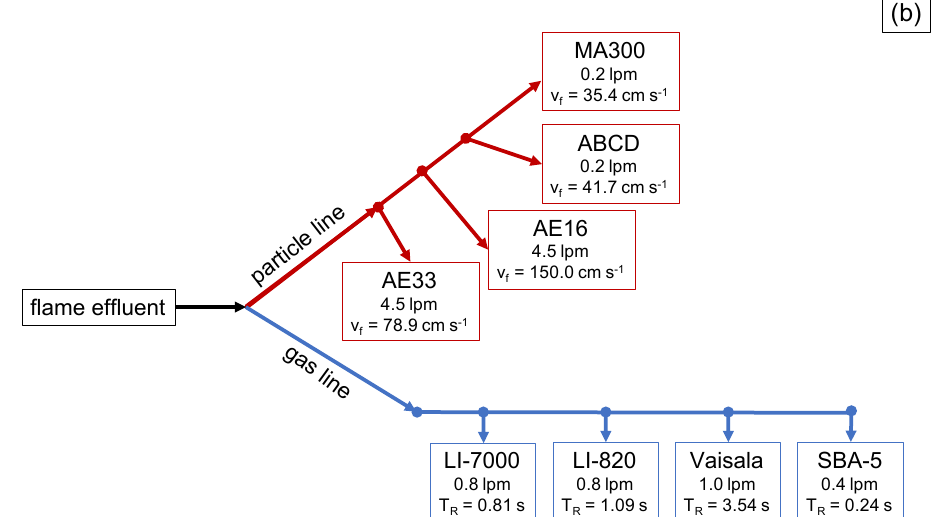
Figure A3. ( a ) Arrangements of sensors sampling the e ffl uent of the inverted flame during laboratory